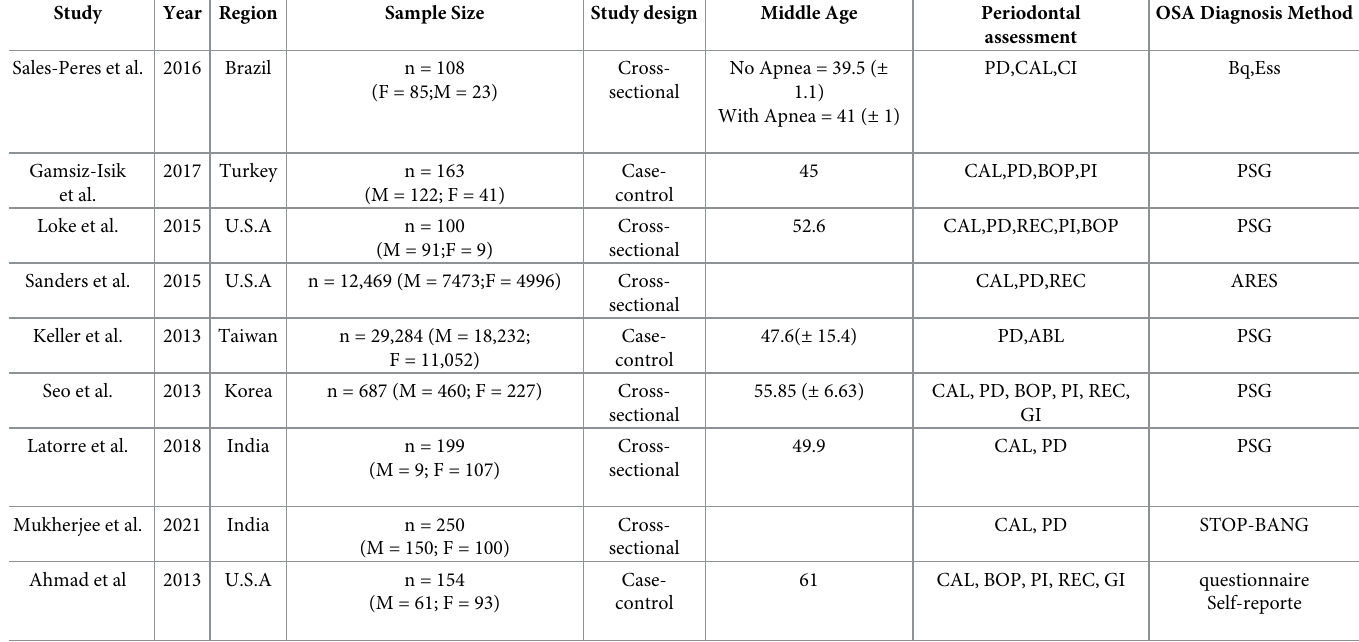
Table 1. Data extracted from the included studies.